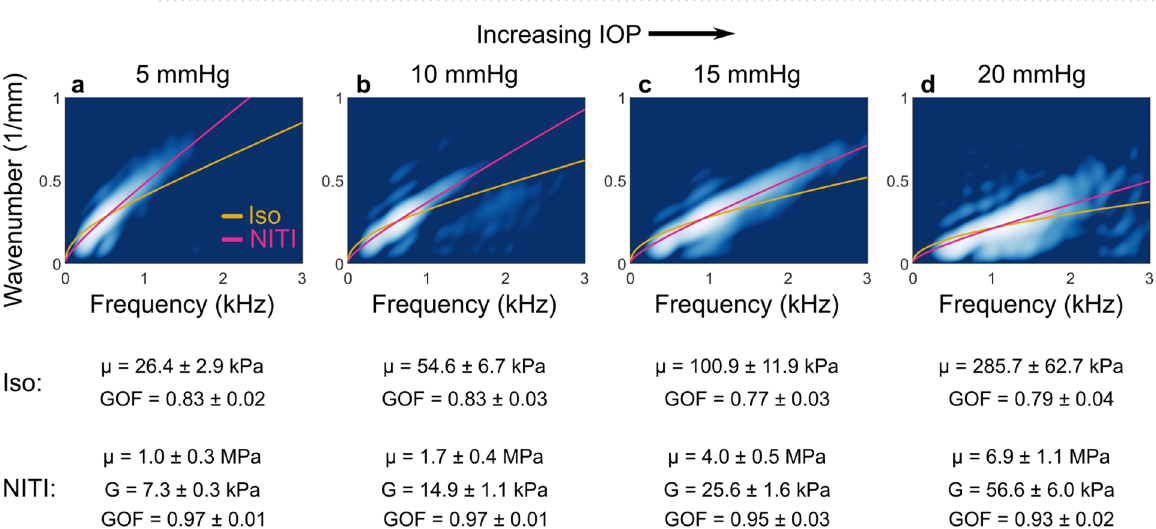
Figure 4. AμT-OCE estimation of elastic moduli in an isotropic phantom and ex vivo porcine cornea. ( a ) OCE experiments in an isotropic thin PVA phantom bounded above by air and below by water. ( b ) The guided wave fields excited by AμT are extracted at the phantom surface (XT plot) and a 2D Fourier transform is applied to obtain the frequency-wavenumber spectrum ( c , presented on a log scale over a 20 dB display dynamic range). Dispersion curves for an isotropic material are then fit to the spectrum ( c , yellow line). The behavior is markedly different from porcine cornea ( d ) in both the XT plot ( e ) and wavenumber-frequency spectrum ( f ). Isotropic and NITI model best fits are shown in ( f ) along with parameter estimates and goodness-of-fit metrics (GOF, see Supplementary Note 7).